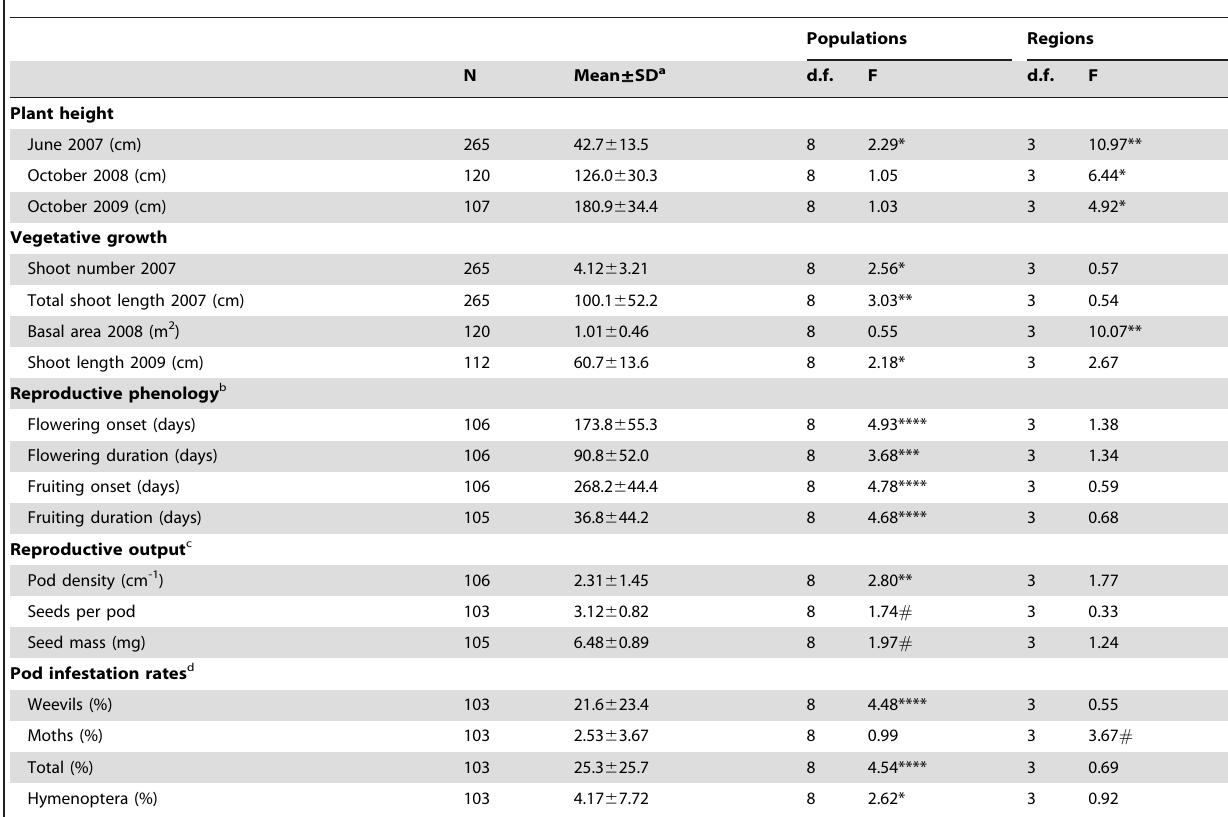
Table 2. Results of nested ANOVA for 18 traits of Ulex europaeus plants grown in a common garden.